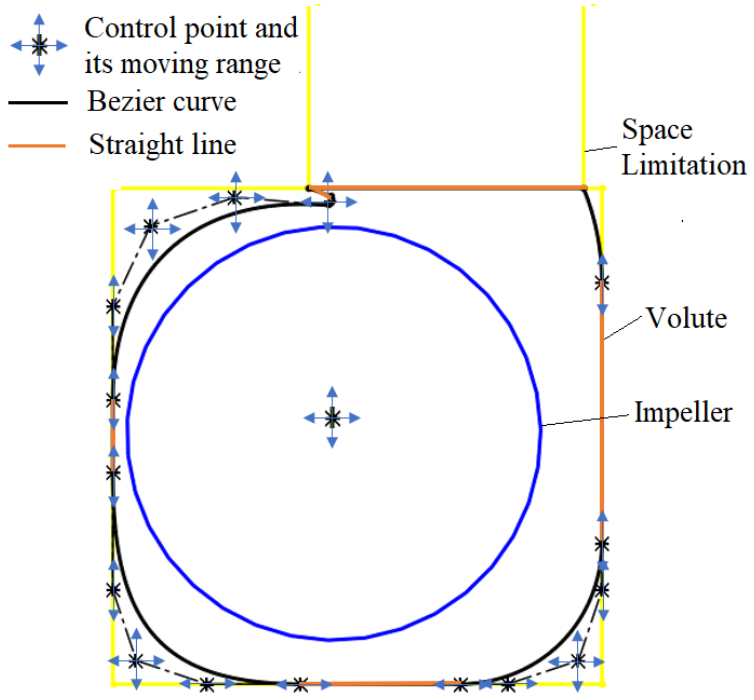
Figure 13. Parametric diagram of the RRVP volute.